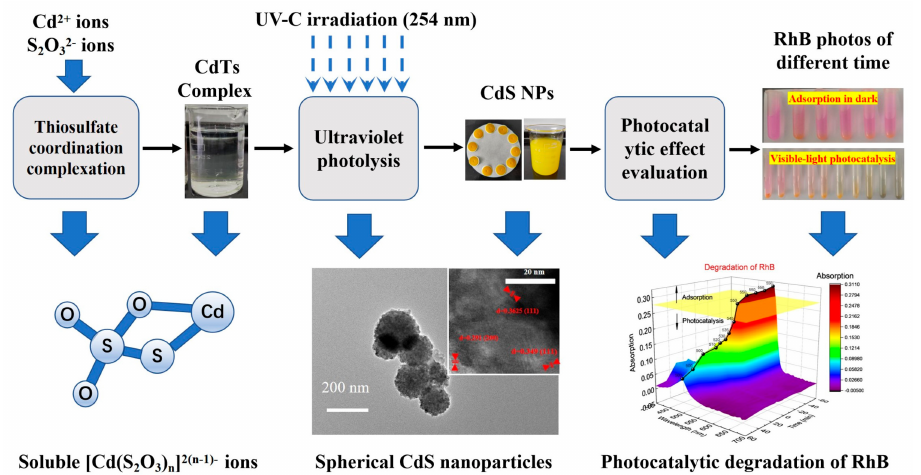
Figure 1. Flow chart of the whole